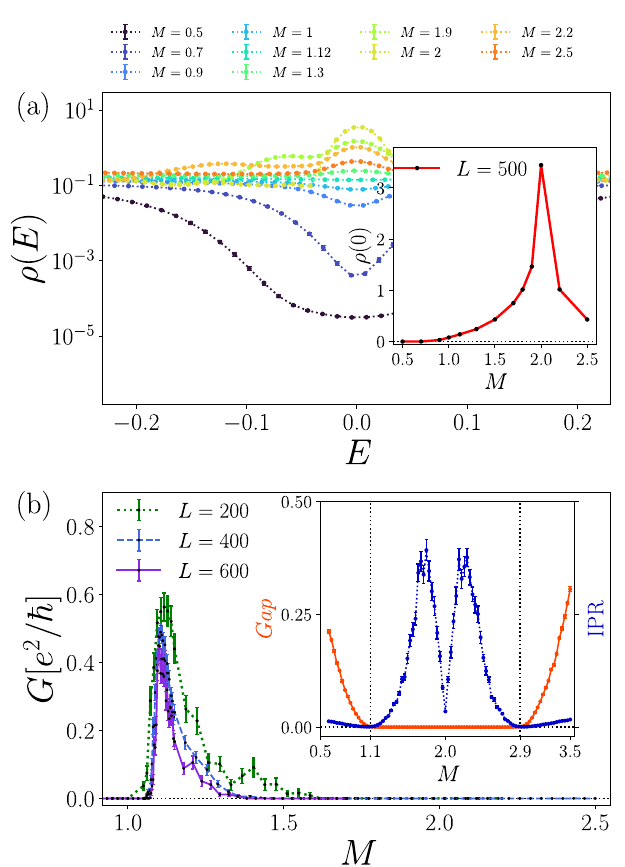
Fig. 3 Spectral insulator-Anderson insulator transition. a Con fi guration- averaged normalized density of states ρ ( E ) for the Hamiltonian (1), shown for different mass parameters M at linear system size L = 500 with second- nearest-neighbour t 2 = 0. Inset shows the behaviour of ρ ( E ≈ 0) as M is varied. The feature at M = 2 originates from a gapless point of the Hamiltonian (1) on a square lattice. b Con fi guration-averaged two-terminal conductance G at t 2 = 0. Inset displays the averaged spectral gap and inverse participation ratio for L = 90 as a function of M . ( t 2 , M c ) = (0, 1.1) and ( t 2 , M c ) = (0, 2.9) denote the gapped-gapless transition points, with the gapless region hosting localized